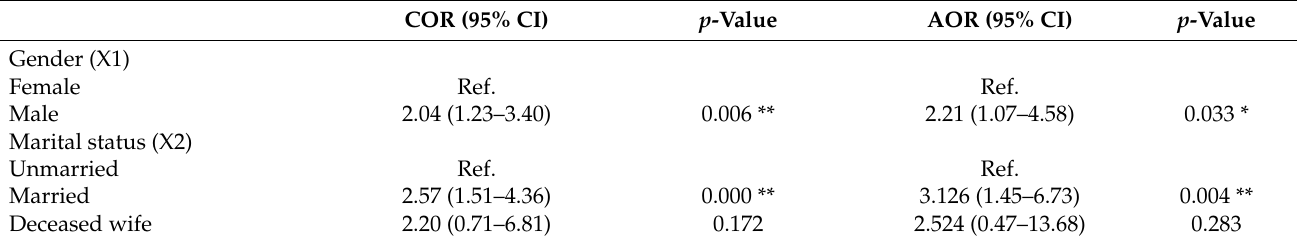
Table 3. Results of the binary logistic